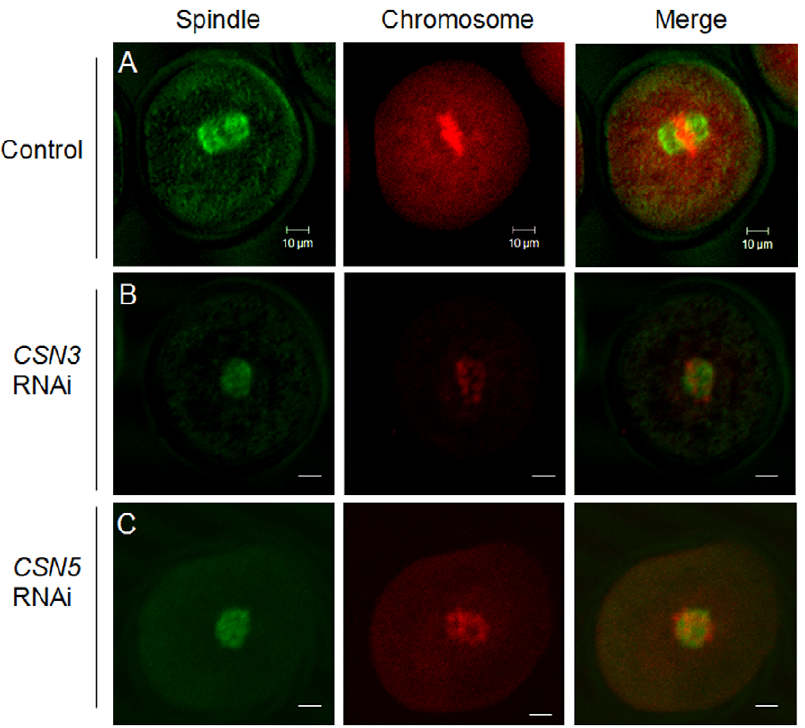
Figure 6. Immunofluorescence staining of the spindle and chromosomes. Spindles were stained with a -Tubulin antibody (green) and chromosomes were counterstained with propidium iodide (red). (A) Control MI oocytes cultured for 8 h. (B, C) RNAi-mediated knockdown of CSN3 (B) and CSN5 (C) arrested oocytes at the MI stage and the oocytes showed abnormally aggregated spindle and chromosomes. Left panel, spindle structure; middle panel, chromosome; right panel, merged image. Bar=10 m m.